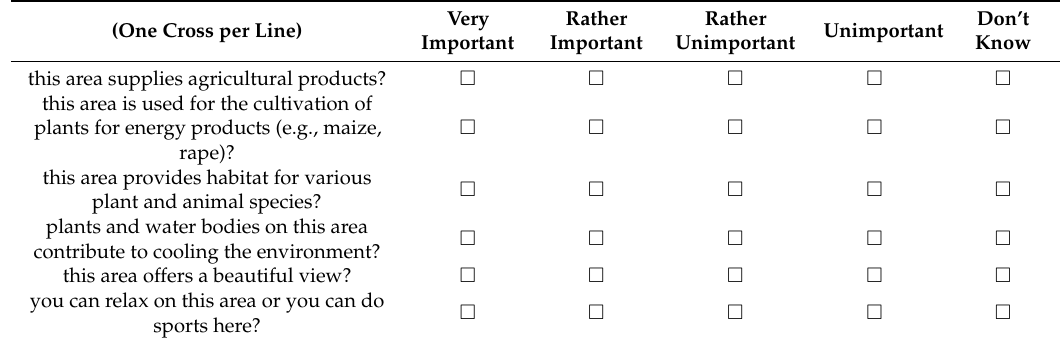
Table A2. Household survey questionnaire (translated). Household Survey concerning green and open spaces in urban housing areas (excerpt). 3. Now I would like to hear your very personal assessment of possible uses of this area. Please indicate whether the aspect mentioned is very important, rather important, rather unimportant, or unimportant for you. How important is it to you that . . . .